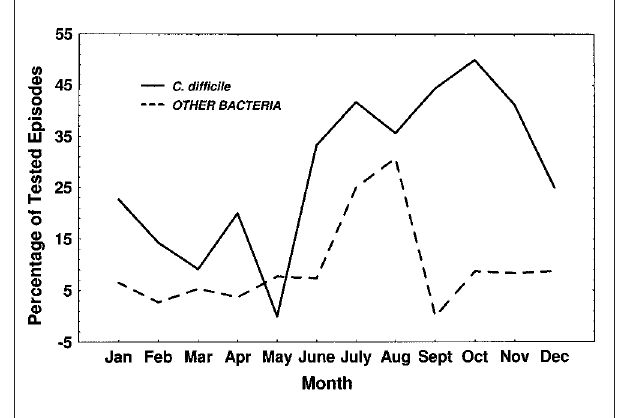
Figure 2) Seasonal distribution of all bacterial-associated diarrhea at the Alberta Children’s Hospital, Calgary, Alberta from April 1, 1993